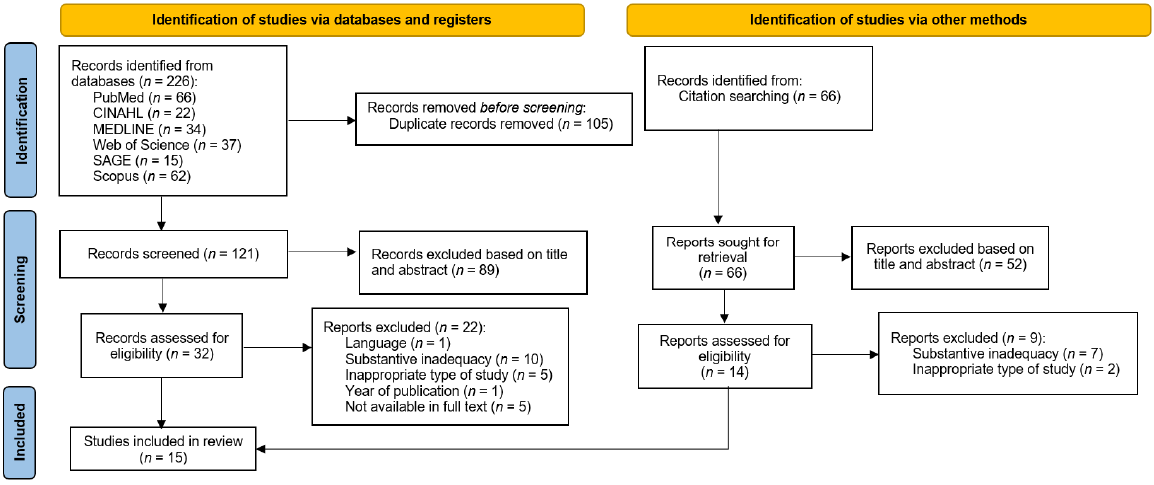
Figure 1. Flow diagram [34].